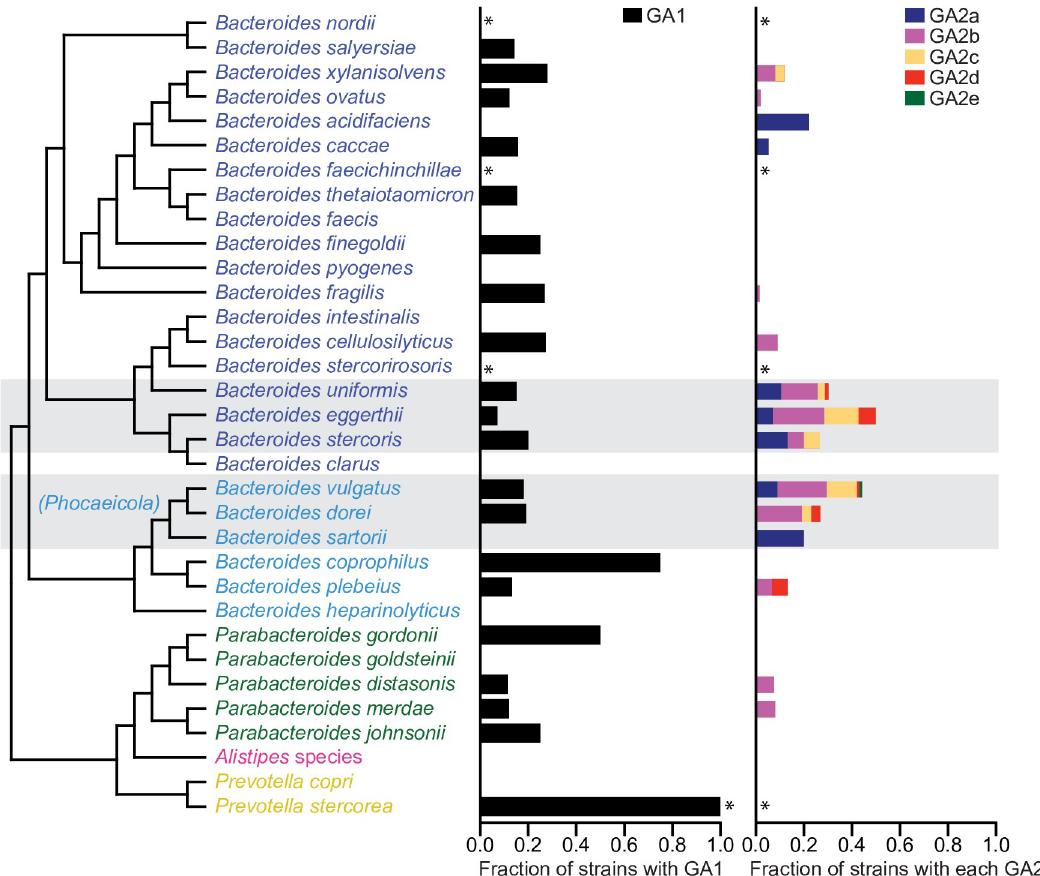
Fig 2. Abundance of GA1 and GA2 loci in different Bacteroidales species. Shown is the fraction of strains within each species harboring each type of GA. � Three or less sequenced isolates. Strains with no species call were not included. Shaded boxes highlight the species with high GA2